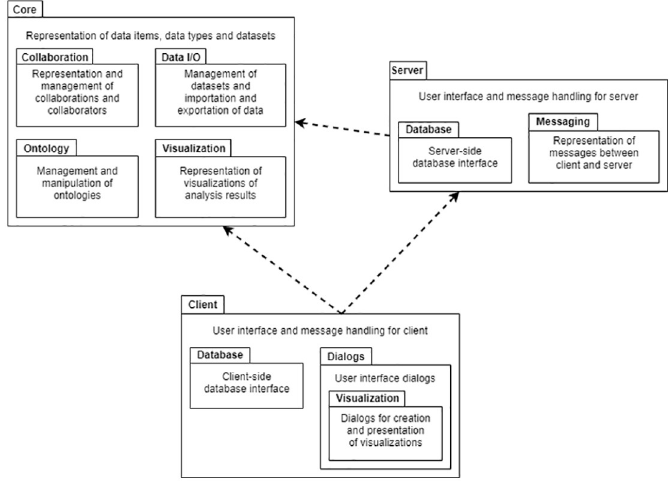
Fig 4. Software architecture. Modules and packages of the collaboration platform. Arrows indicate dependency relationships between